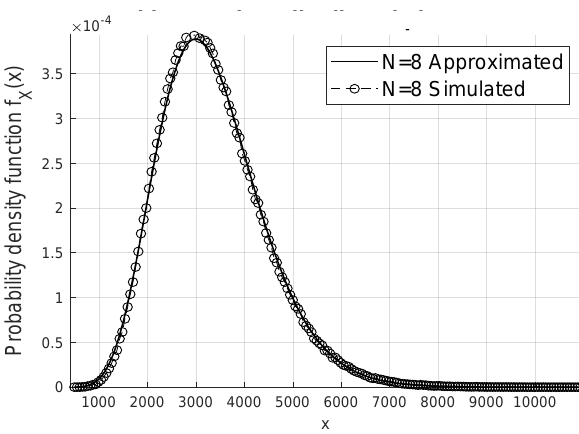
Figure 3. Approximated Gamma Distribution of (cid:107) w (cid:107) 2 with Von Mises κ = 2 errors.